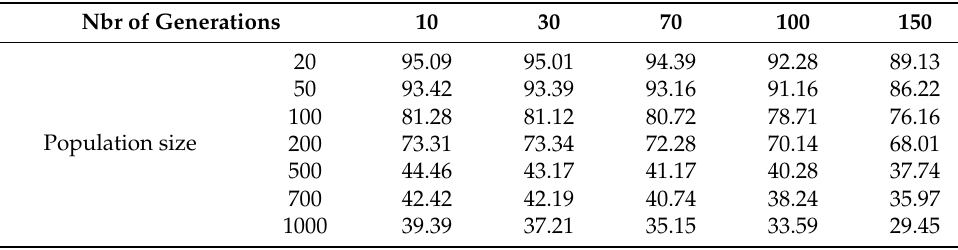
Table 4. Performance of the genetic objective value (in terms of cost) with different number of